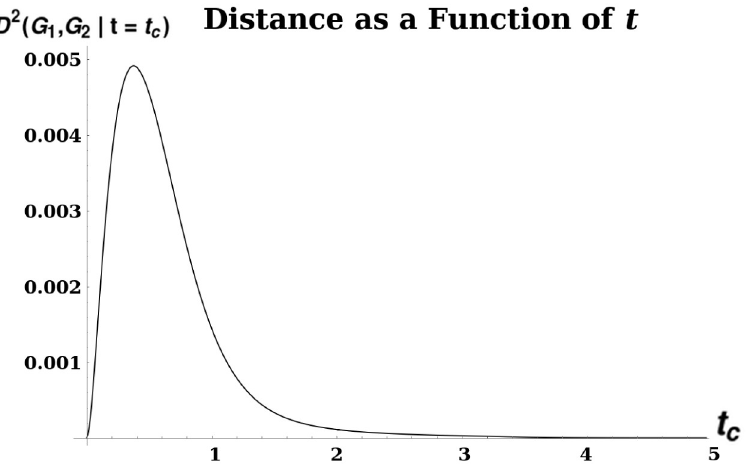
Fig 3. A plot illustrating unimodality of diffusion distance. D 2 was calculated between two grid graphs Sq 7 and Sq 8 of size 7 × 7 and 8 × 8, respectively. The distance is given by the formula D 2 Sq � � inf a > 0 inf Pe t a L ð Sq 7 Þ (cid:0) e t a L ð Sq 8 Þ P P j C ð P Þ